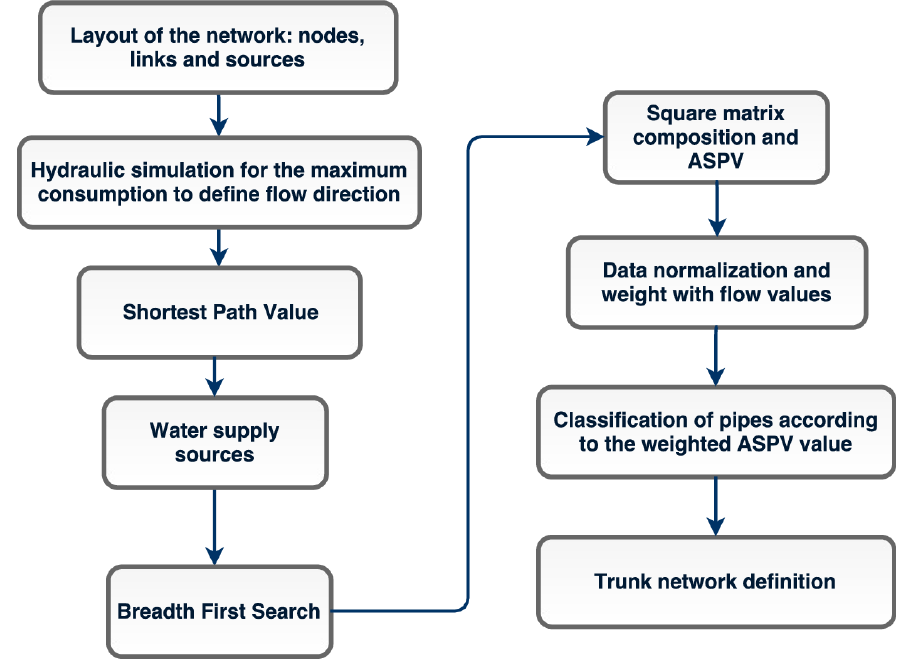
Figure 1. Flowchart to obtain the Trunk Network.